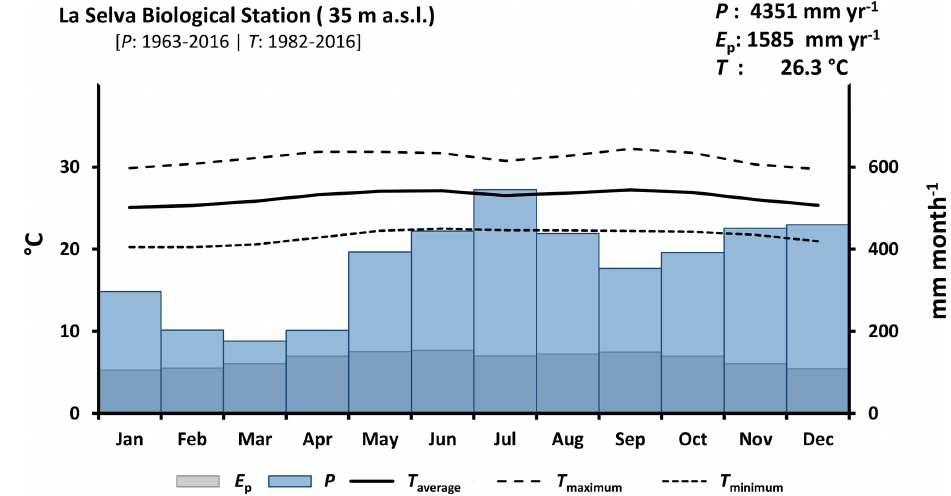
Figure 2. Climate diagram of La Selva Biological Station based on records of 54 years of precipitation ( P ) and 35 years of temperature ( T ) (source: https://tropicalstudies.org/, last access: 6 April 2018). The potential evaporation ( E p ) was estimated with the temperature data and Thornthwaite equation (Thornthwaite,